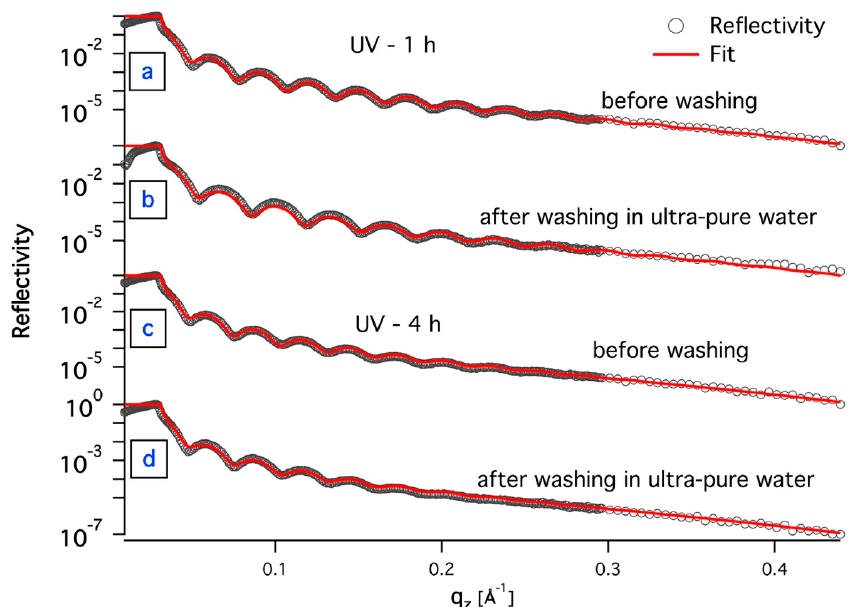
Figure 1. X-ray reflectivity curves of photocleavable junction linking the two blocks (PS- h ν -PEO) ultra-thin film measured in dry state. The reflectivities for the sample cleaved with UV for 1 h are represented in ( a ) before and ( b ) after washing out the pore material with ultra-pure water. The reflectivities for the sample cleaved with UV for 4 h are represented in ( c ) before and ( d ) after washing out the pore material with ultra-pure water. The black line represents the measured curve and the red line is the fit simulated using the Parratt algorithm.